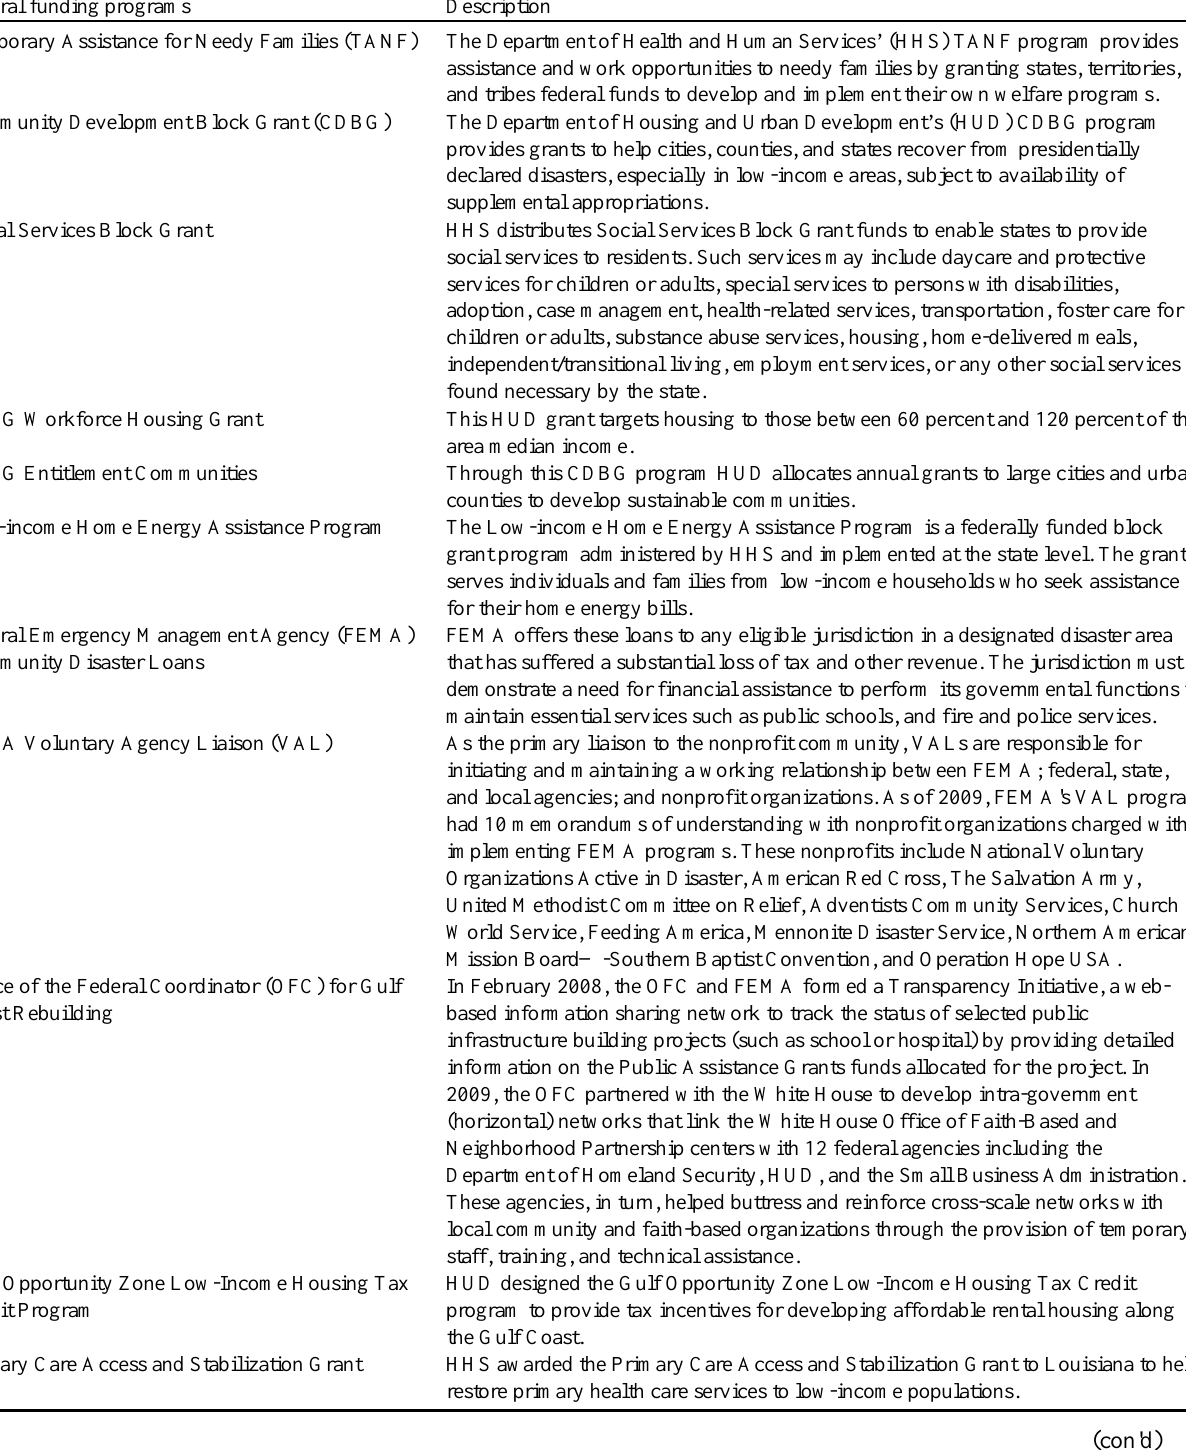
Table 2 . Selected federal funding programs providing support to victims of Hurricane